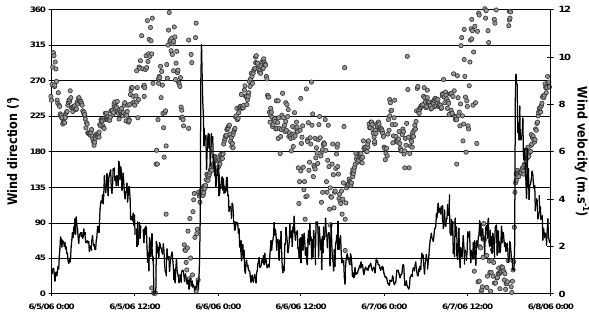
Fig. 13. 5-min surface wind directions (grey dots) and velocities (black line) measured in Cinzana from 5 to 8 June